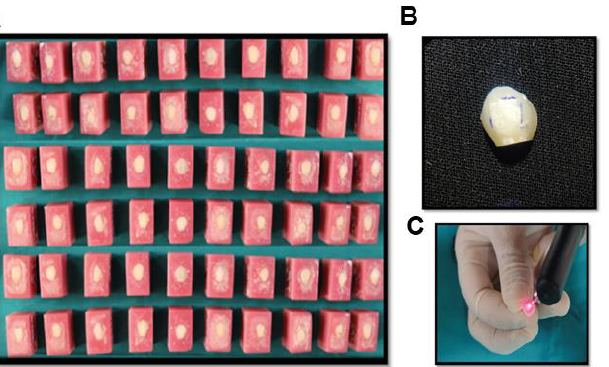
Figure 9. ( A ) Natural teeth mounted acrylic block, the prepared teeth for the experiment, ( B ) demineralized tooth specimen, and ( C ) assessment using DIAGNOdent instrument.